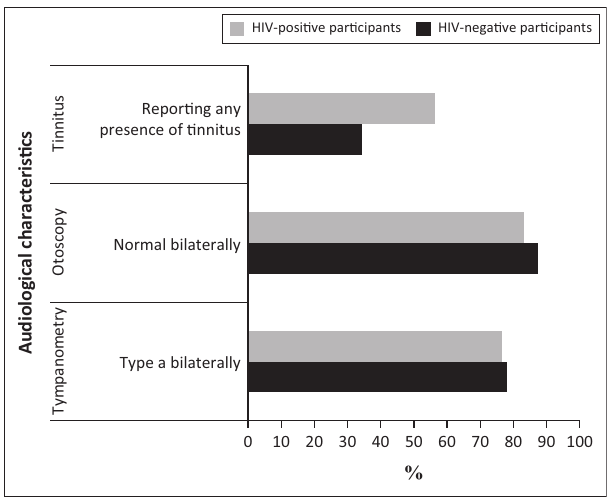
FIGURE 1: Most prevalent audiological characteristics in the two participant groups (HIV-positive participants [ N